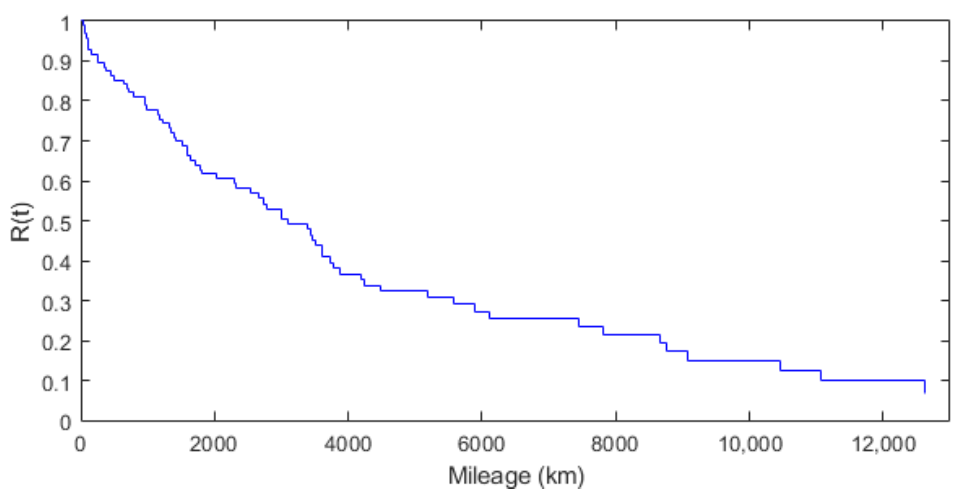
Figure 4. Kaplan – Meier reliability estimation graph. Figure 4. Kaplan–Meier reliability estimation